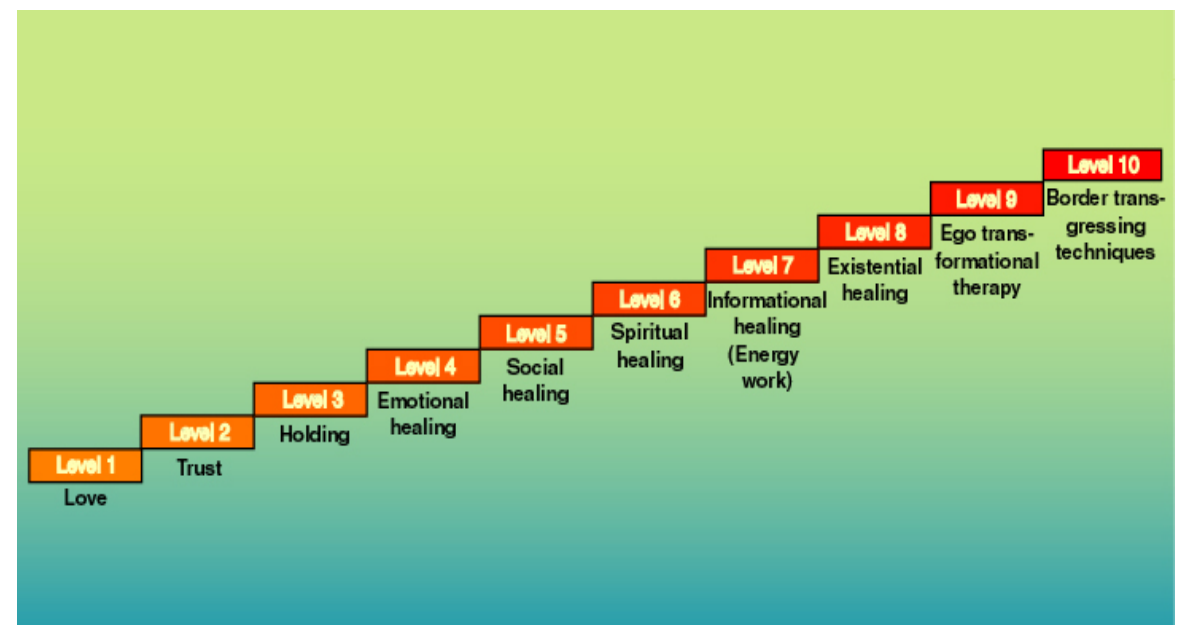
FIGURE 1. The therapeutic staircase of holistic medicine[43]. In therapy, as well as in the training of the therapist, one step must be accomplished before the next step is used. Please take note that vaginal acupressure is a level-8 technique in this system. Level 8 is the most difficult level in the advanced holistic medical practice. Most holistic therapists work at level 3 and 4 and most problems related to health, quality of life, and ability can be solved at this